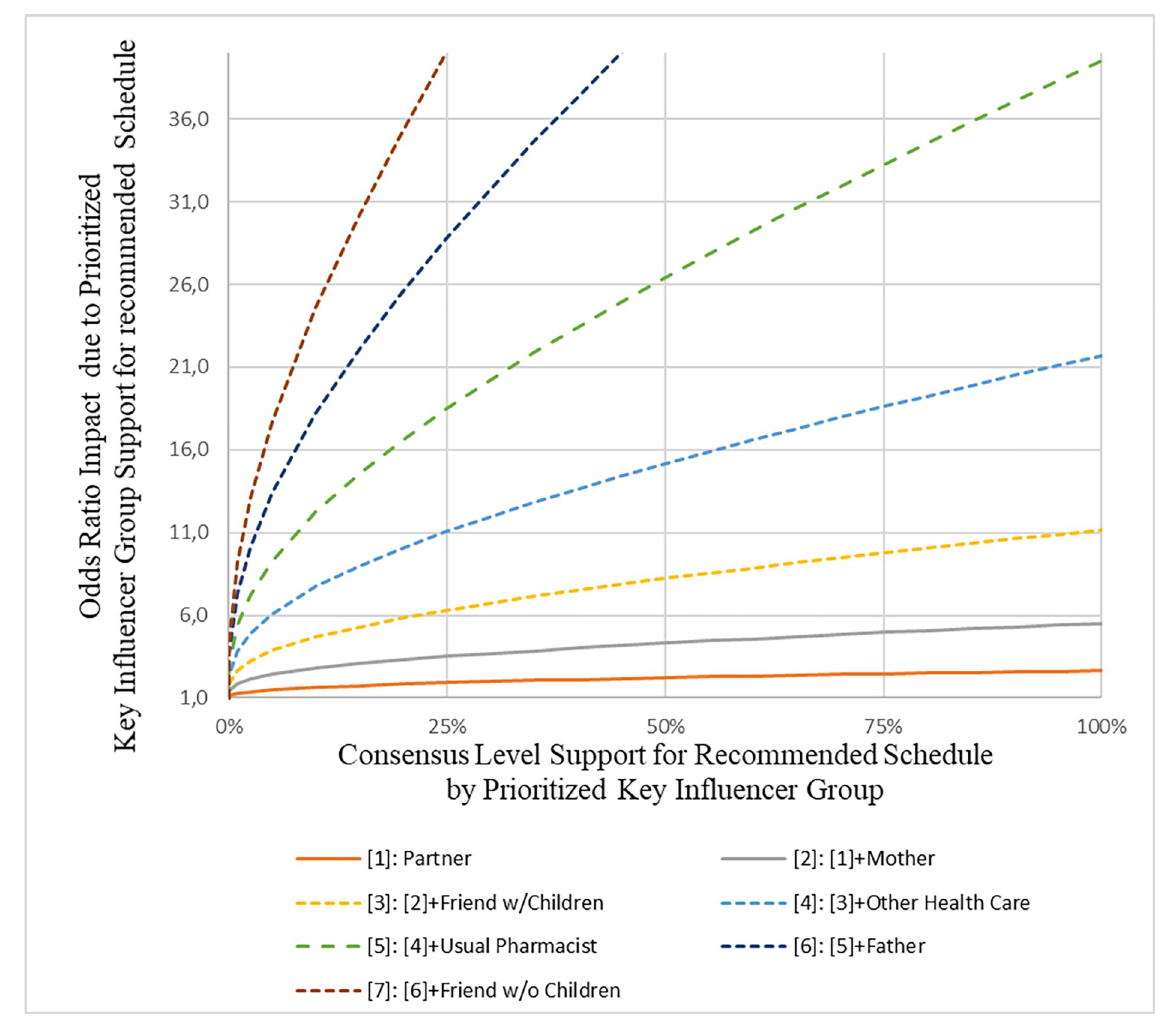
Fig 6. The value of social